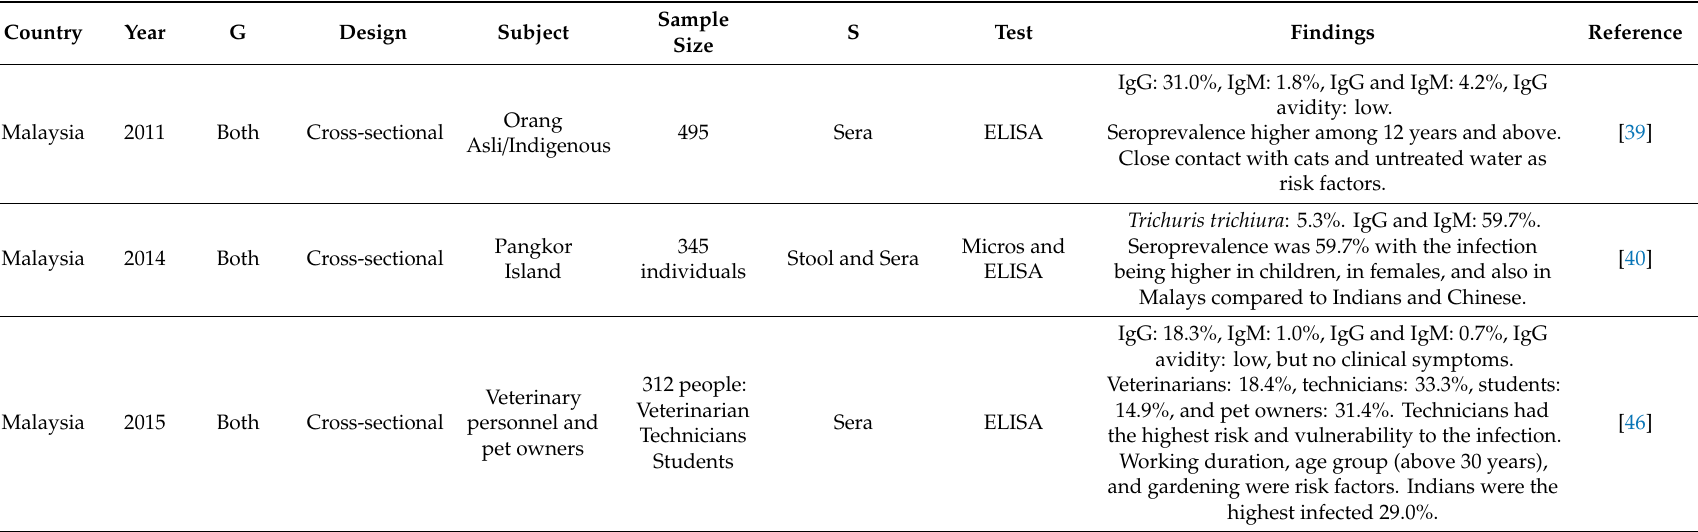
Table 5. Serological prevalence of toxoplasmosis among healthy community members in